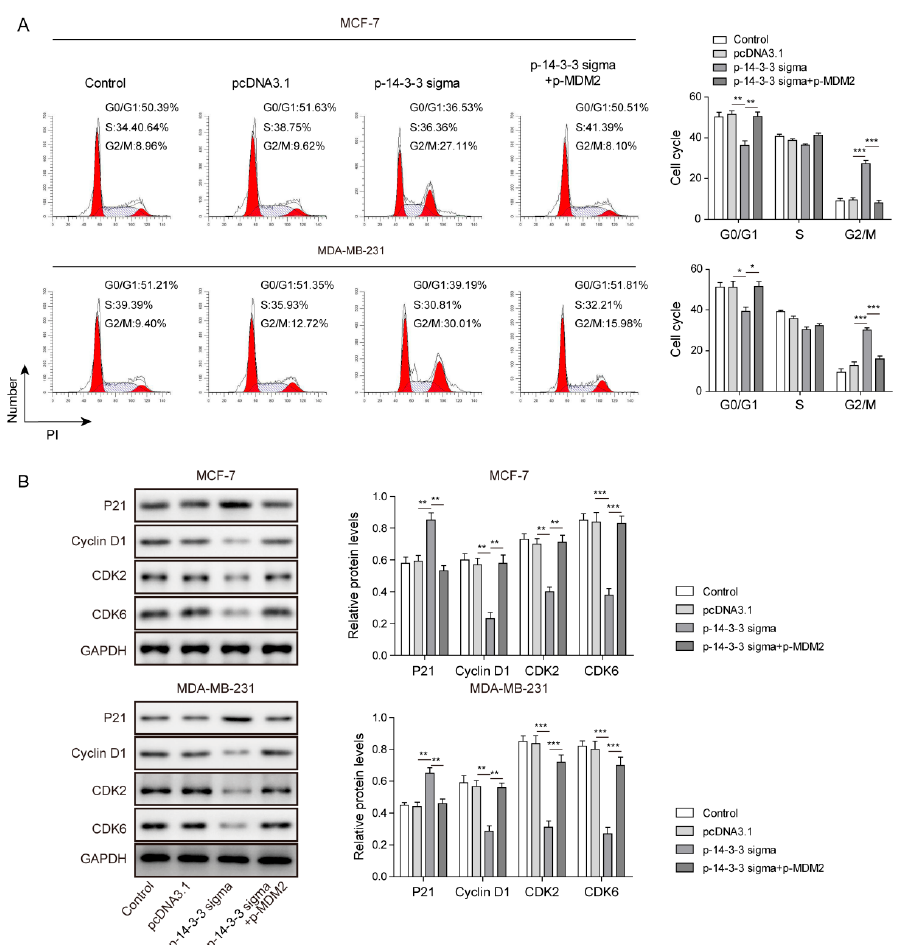
Figure 6. 14-3-3 sigma blocked cell-cycle progression by suppressing MDM2 expression in breast cancer cells. ( A ) Cell-cycle analyses via flow cytometry. ( B ) Relative protein levels of cell-cycle regulatory proteins measured by Western blot. MCF-7 and MDA-MB-231 cells transfected with pcDNA3.1 or p-14-3-3 sigma or co-transfected with p-14-3-3 sigma and p-MDM2. * p < 0.05, ** p < 0.01, *** p < 0.001.